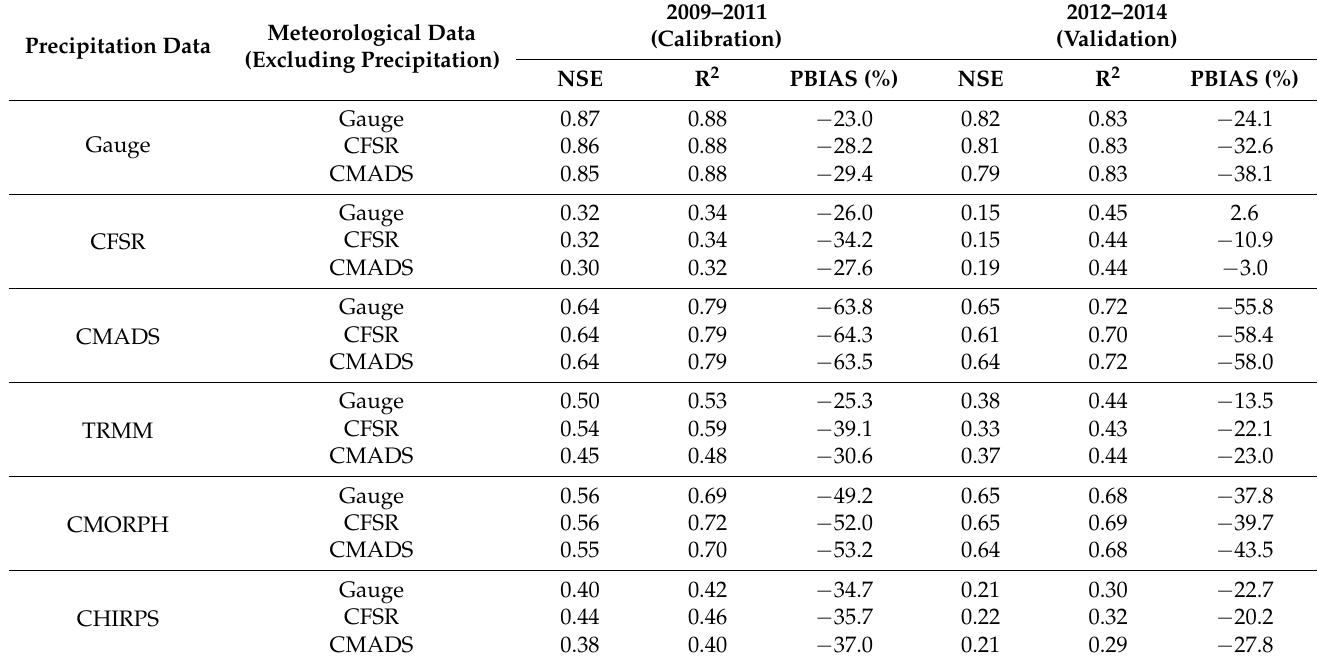
Table 2. Evaluation statistics for the performance of eighteen scenarios in daily streamflow